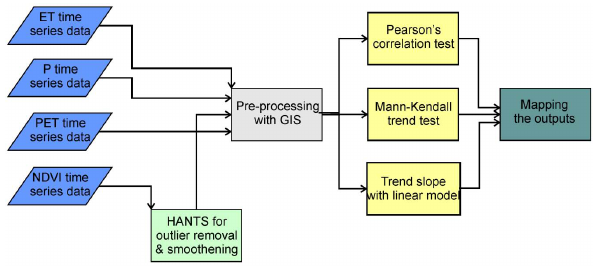
Fig. 3. Flowchart of trend analysis using satellite-based data